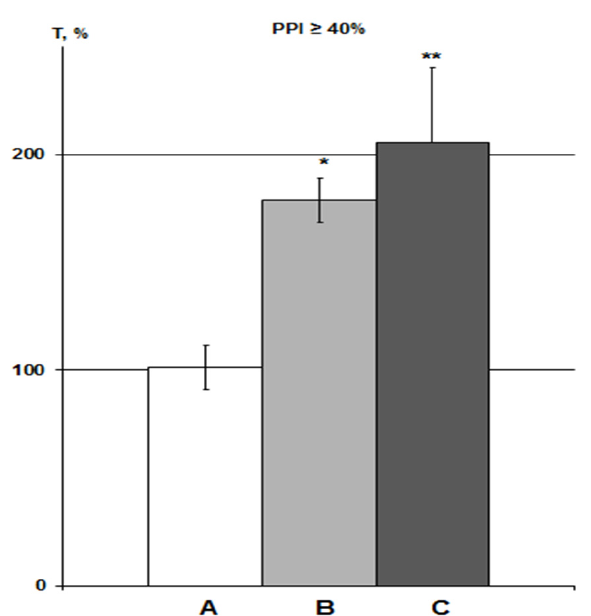
Figure 4. Influence of DMSO on HBH efficiency with IP and iHippo administration. The T values are expressed as in Figure 3 (means ± SEM%). A, control group (n = 11); B, DMSO IP group (n = 6); C, DMSO iHippo group (n = 8). * significant differences with the control group. * p < 0.05; ** p < 0.02. The Wilcoxon–Mann–Whitney test (u-criterion) and Fisher’s exact test (FET-criterion). p values are presented as amended by the Holm-Bonferroni